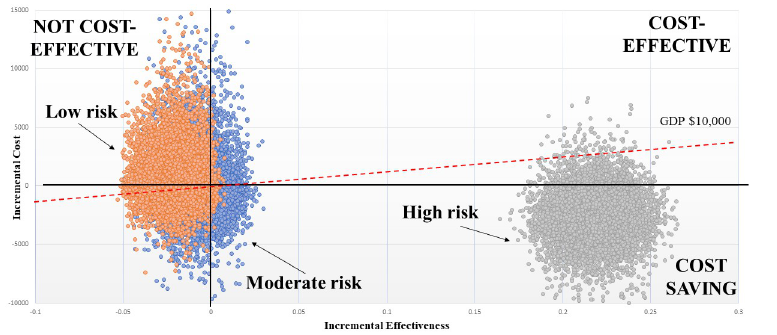
Fig 4. Cost-effectiveness of spirometry to improve patient survival, by ARISCAT risk